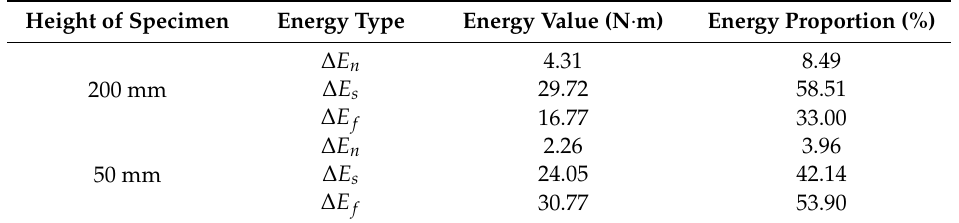
Table 3. Energy increments and proportion of the concrete specimens with different specimen heights at the pre-peak stage.